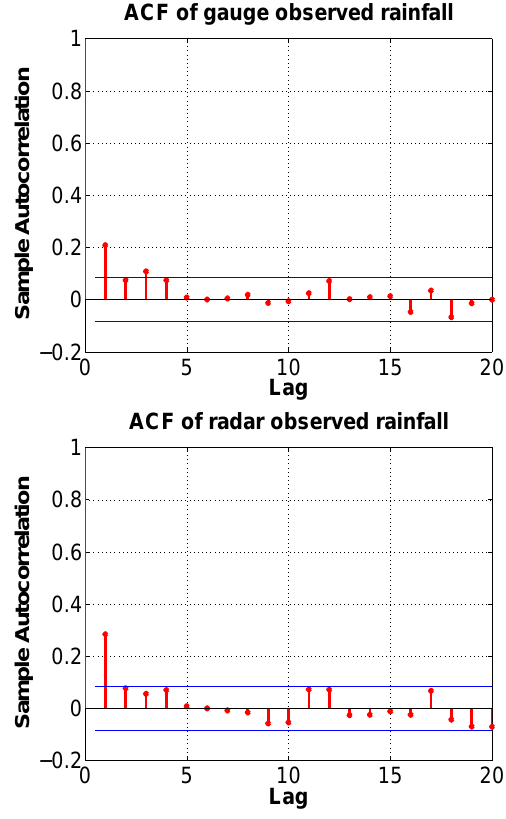
Fig. 4. Autocorrelation function for gauge (top) and corresponding Fig. 4: Autocorrelation function for gauge (top) and cor- radar grid (bottom) at the station responding radar grid (bottom) at the station Garmisch- Partenkirchen.